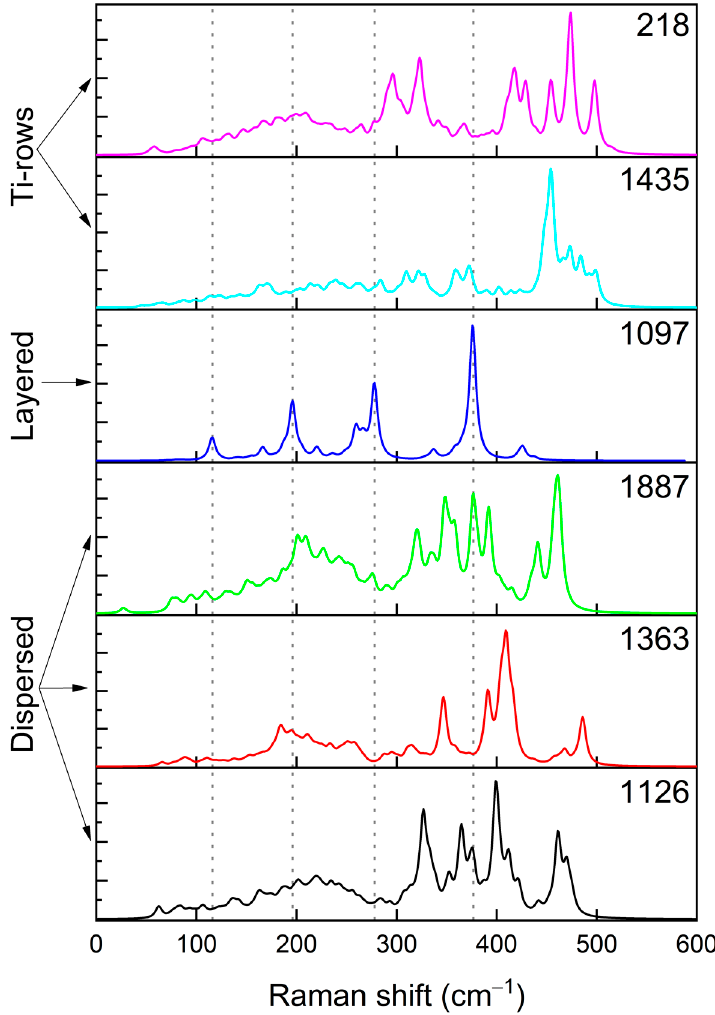
Figure 6. Calculated Raman spectra of the six structures described in Table 4 and Figure 4.